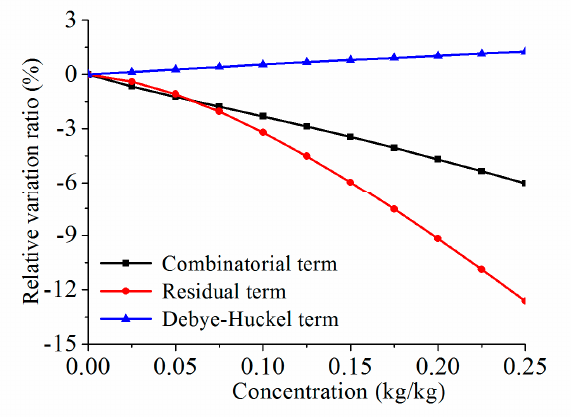
Figure 11. Change ratio of three terms in Equation (18).